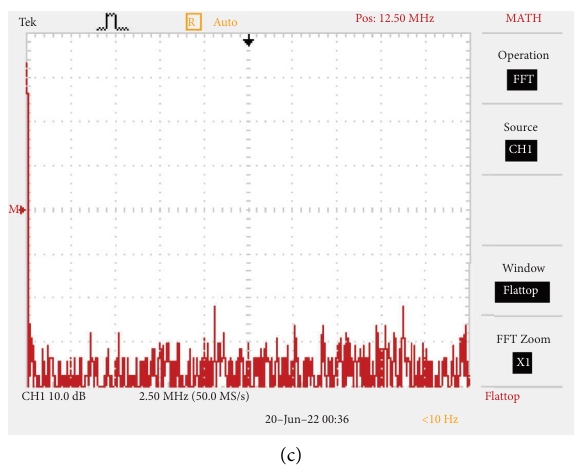
Figure 11: (a) I L 1 at 25kHz, (b) I in at 25kHz, and (c) I in at 2.5MHz with LC